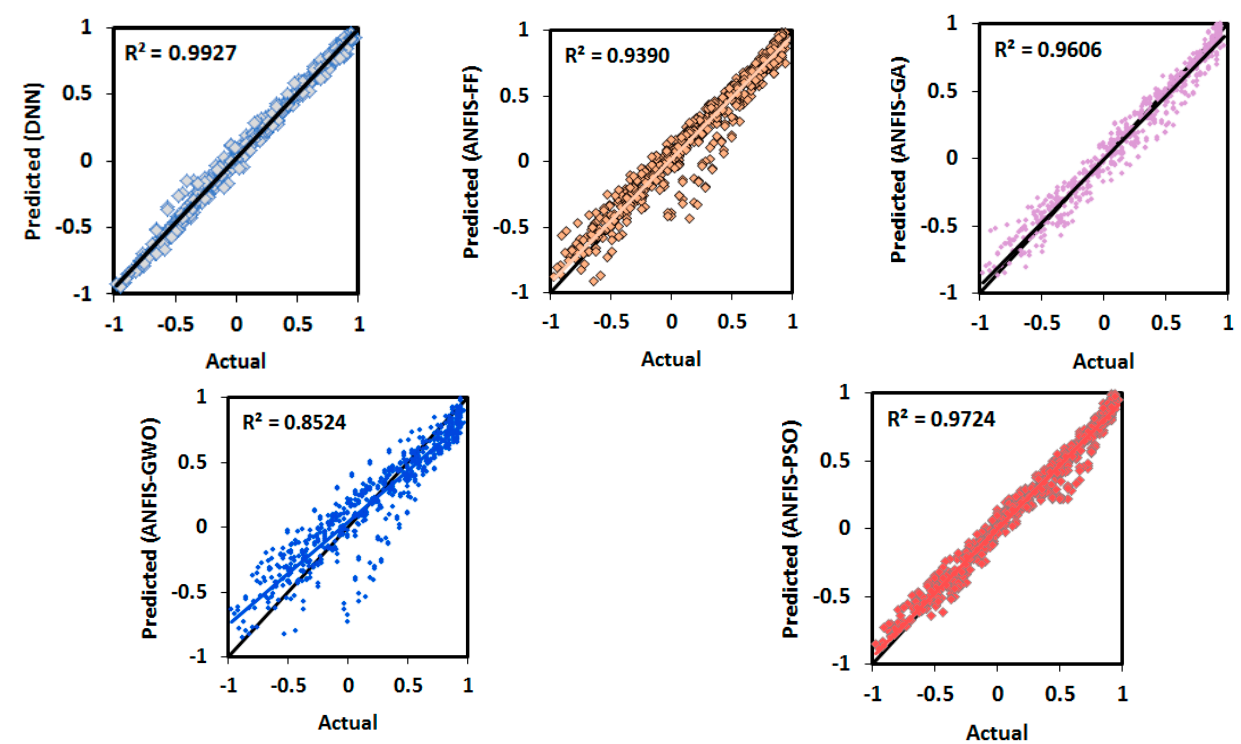
Figure 10. Illustration of actual and predicted strain in longitudinal ( y ) dimension (Training).